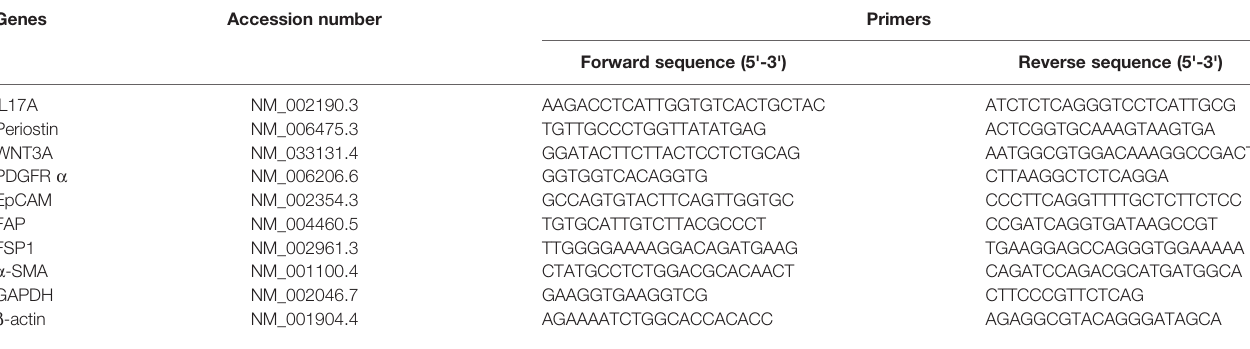
TABLE 4 | Real-time PCR (QPCR) primers for various genes used in this study.